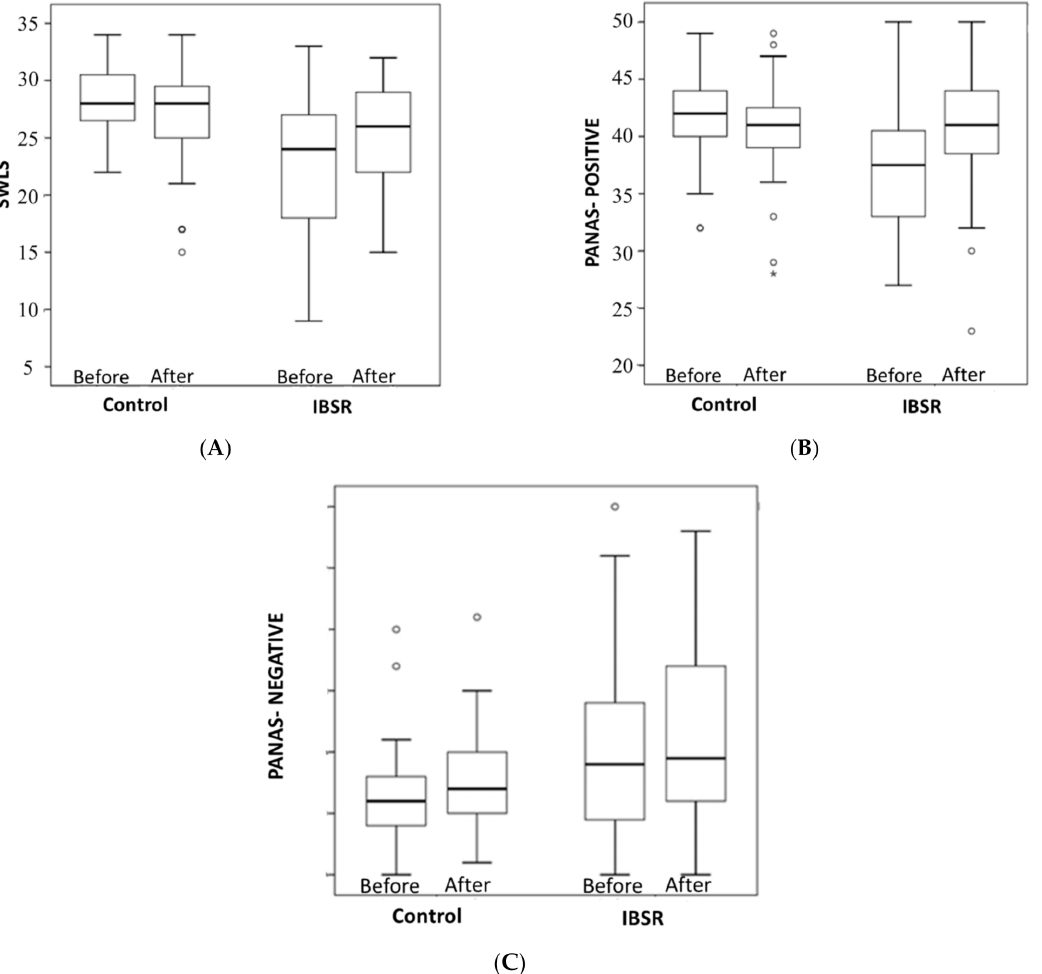
Figure 3. ( A ) Effect of IBSR intervention on Satisfaction with Life Scale (SWLS) in comparison to control group. Data is displayed as box plot of both groups. * p < 0.05. ( B ). Effect of IBSR intervention on Positive Affect sub-scale (PANAS-positive) in comparison to control group. Data is displayed as box plot of both groups. * p < 0.05. ( C ). Effect of IBSR intervention on Negative affect sub-scale (PANAS-negative) in comparison to control group. Data is displayed as box plot of both groups. * p <